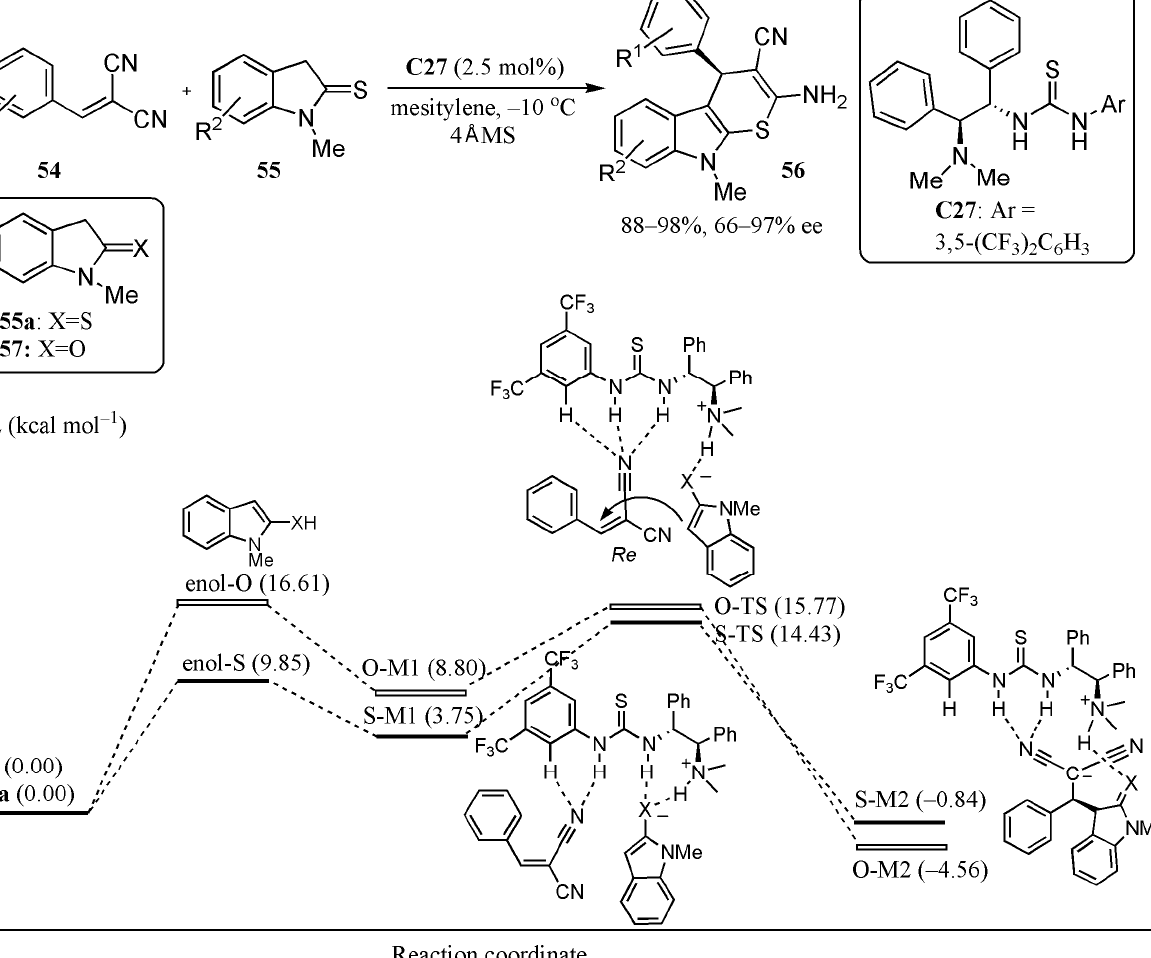
Figure 35. Enantioselective synthesis of thiopyrano-indole-annulated heterocycles via a formal thio [3+3]-cyclization [69].